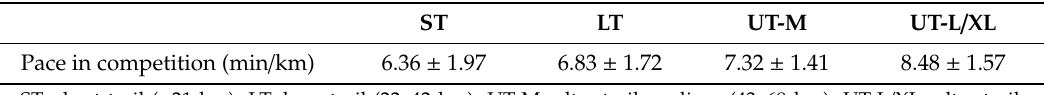
Table 1. Descriptive statistics of pace in di ff erent categories of trail